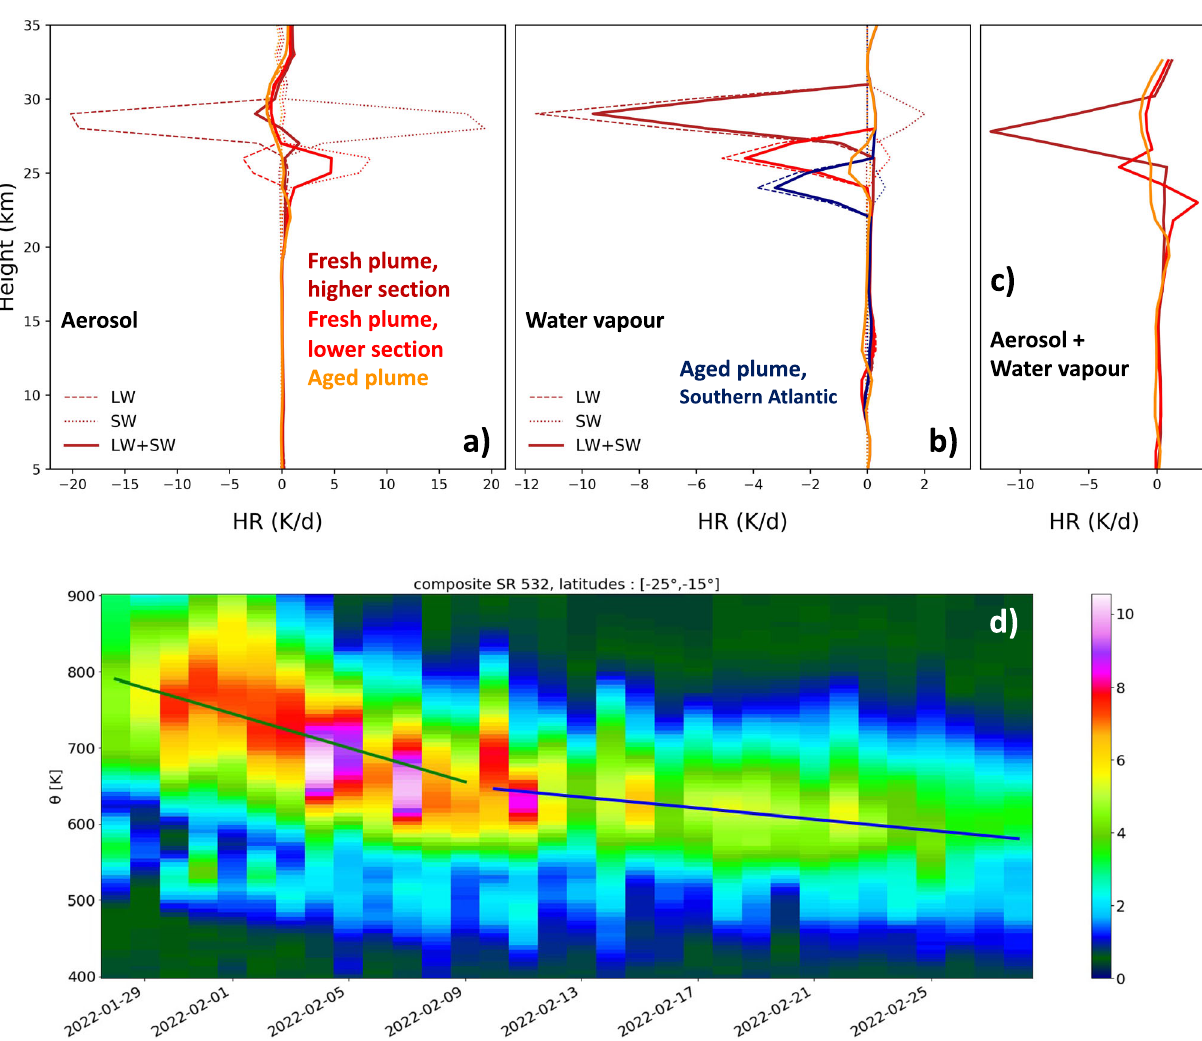
Fig. 5 Stratospheric radiative cooling due to the HT plume and plume descent. Aerosol ( a ), water vapour ( b ) and total plume ( c ) LW (dashed lines), SW (dotted lines) and total (solid lines) radiative heating rates (HR) for the basic cases discussed in the text: fresh plume, higher section (dark red), fresh plume, lower section (red) and aged plume (orange). The additional case of the southern Atlantic pro fi le is presented for water vapour only in b (blue). The CALIOP aerosol observations and water vapour radio-sounding, even if representative of the same plume sections, are taken at different time intervals (radio-soundings are taken 2 days later than CALIOP overpasses of the early plume), thus CALIOP pro fi les are vertically shifted to match the water vapour enhancements observed with radio-sounding. CALIOP 532 nm attenuated backscatter ratio (SR) averaged daily over all night traces in the zonal direction and between 15°S and 25°S in latitude ( d ). The fi t is performed over all pixels where SR > 4 and for the two periods Jan 28 – Feb 09 (green line, − 11.3 K/d) and Feb 10 – 28 (blue line, − 3.6